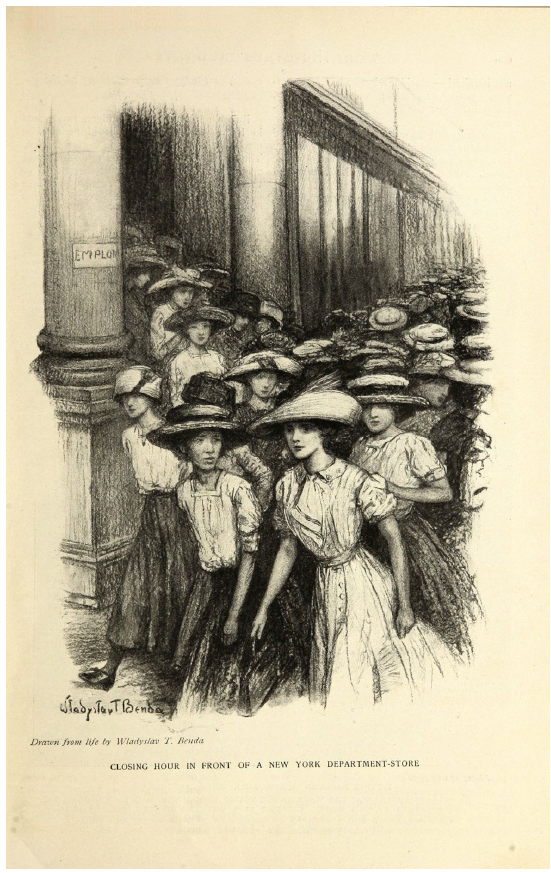
Figure 8. Closing hour at a New York Department Store. McClure’s Magazine 35.6, Oct. 1910, p. 599. The Modernist Journals Project. Available online: https://modjourn.org/issue/bdr554781/ (accessed on 29 August 2022).